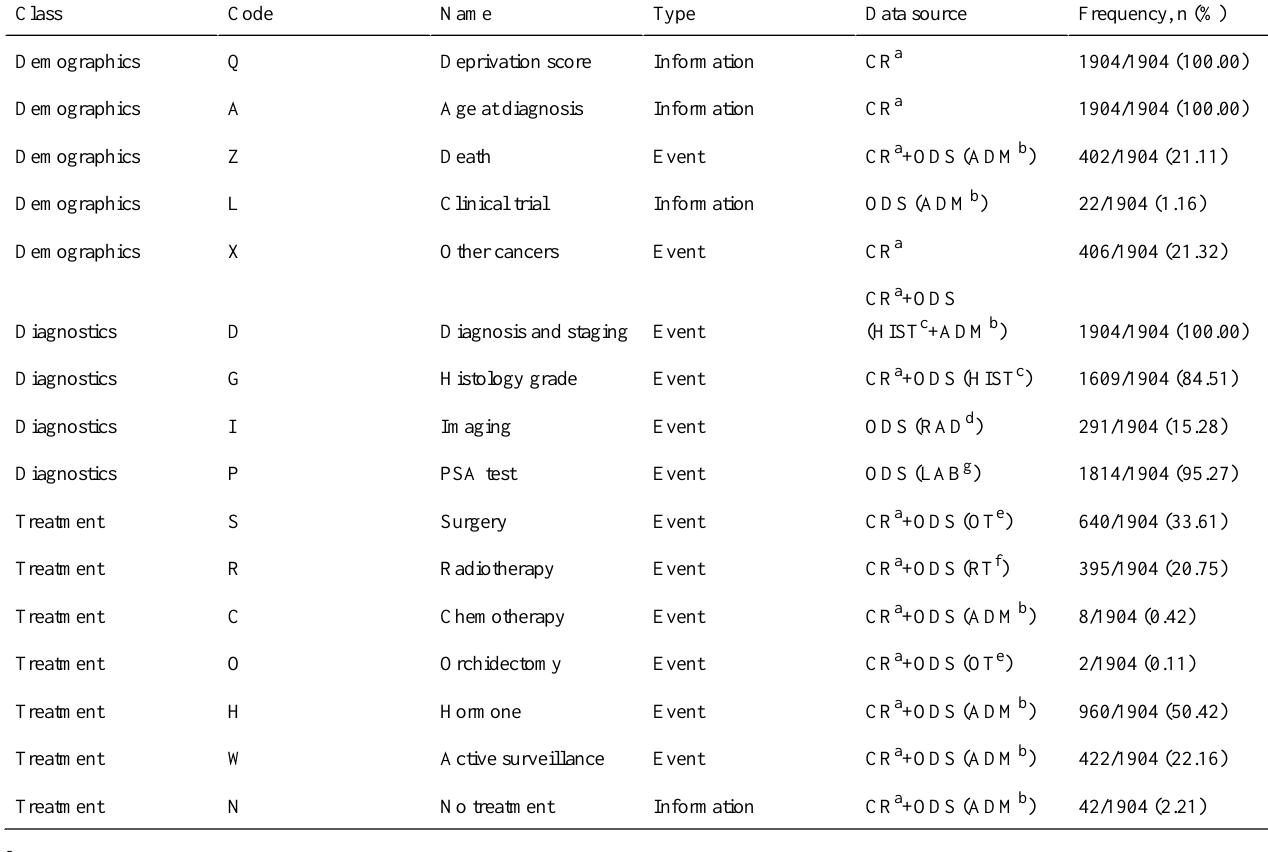
Table 2. Pathway dictionary for prostate